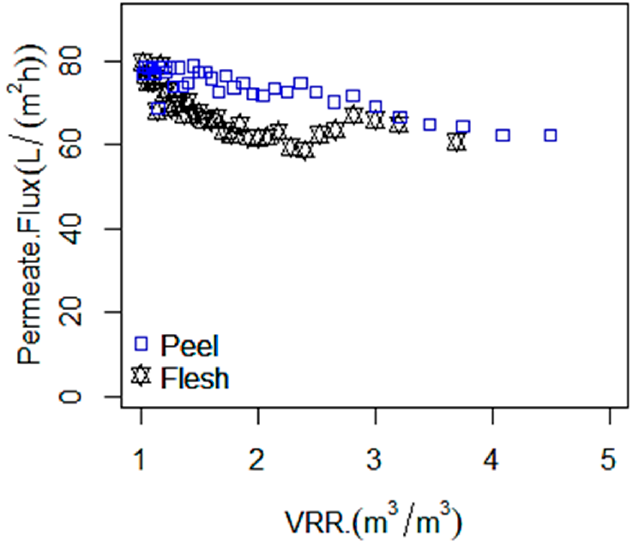
Figure 4. Permeate flux with VRR during the concentration process by RO membrane (X20). From pure water flux measurements, after the concentration process of beetroot peel and flesh extracts, fouling resistances of membranes were calculated. Those are depicted in Figure 5. No significant difference in fouling resistance is observed between peel and flesh